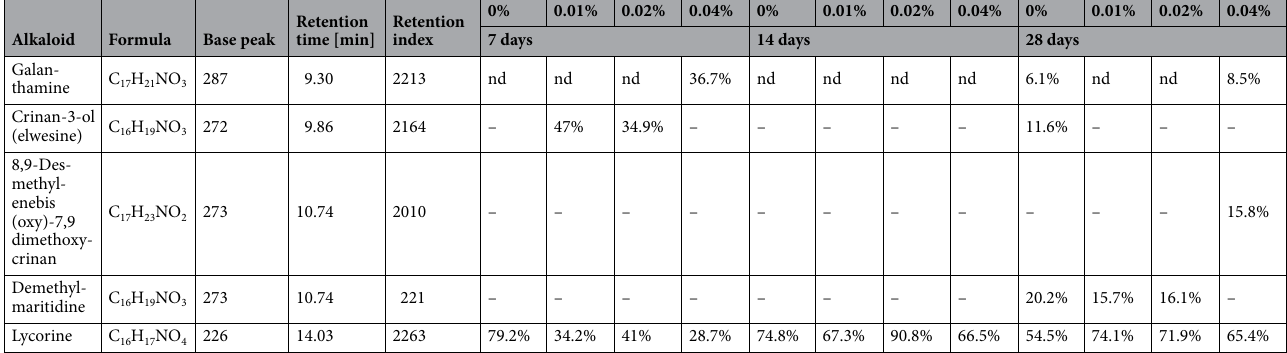
Table 3. Amaryllidaceae alkaloids identified by GC–MS (% of TIC) in L. aestivum in vitro plants during feeding with various concentrations of Paenibacillus lautus strain PLV (0%, 0.01%, 0.02% and 0.04%). TIC, Total Ion Chromatogram; nd, not detected; (−), no